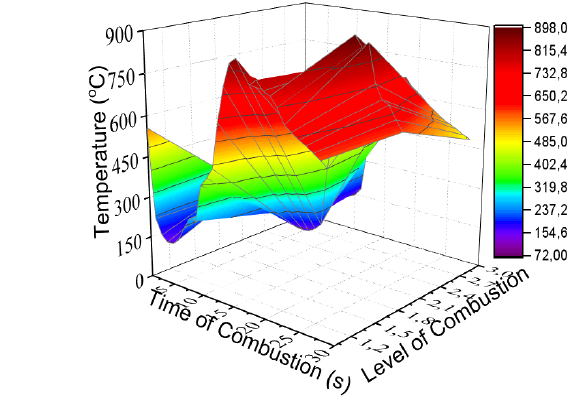
Figure 4. M1 combustion temperature levels of the three different fuels.